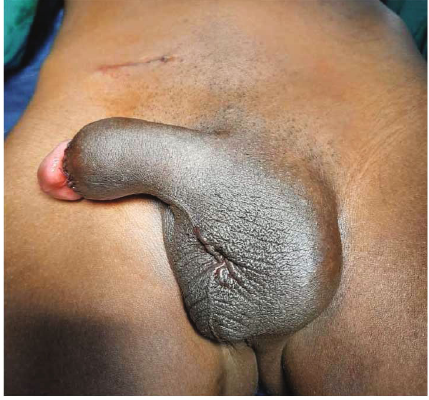
Figure 8: Final aspect after bilateral orchidopexy and routine circumcision.